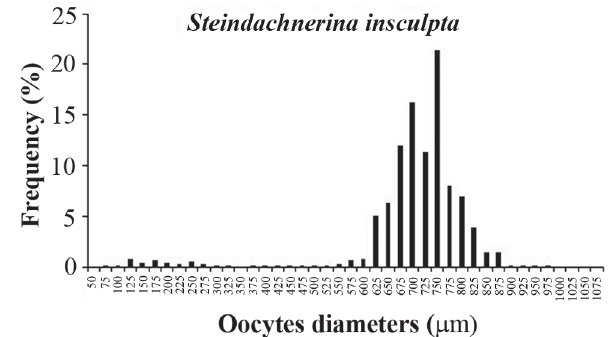
Fig. 5. Frequency distribution of oocytes diameters of Steindachnerina insculpta .